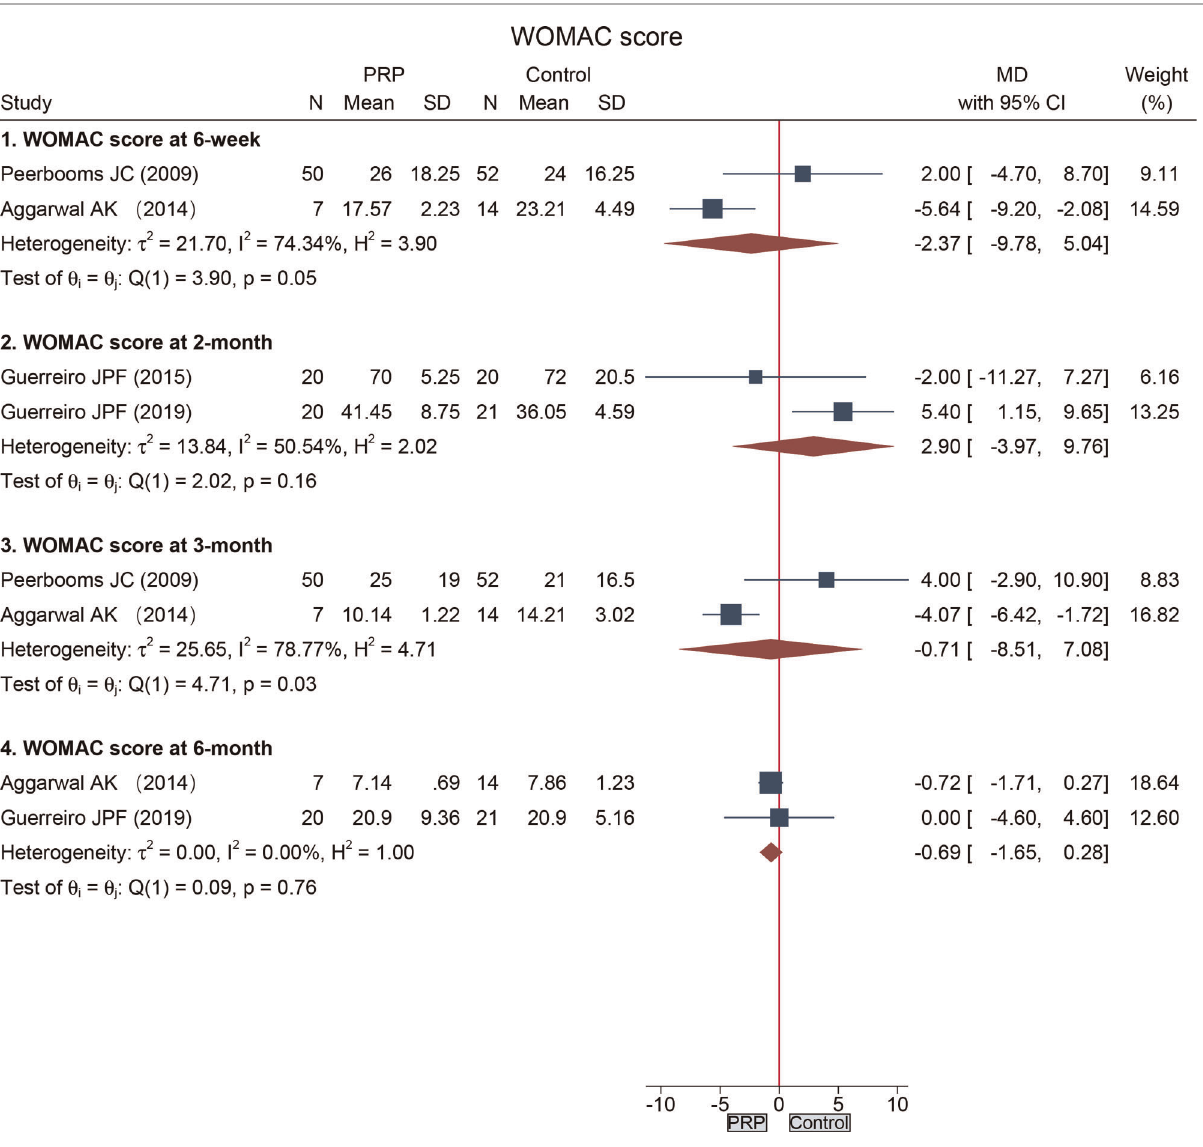
FIGURE 5 | Forest plot presents the pooled results for WOMAC score in the total knee arthroplasty